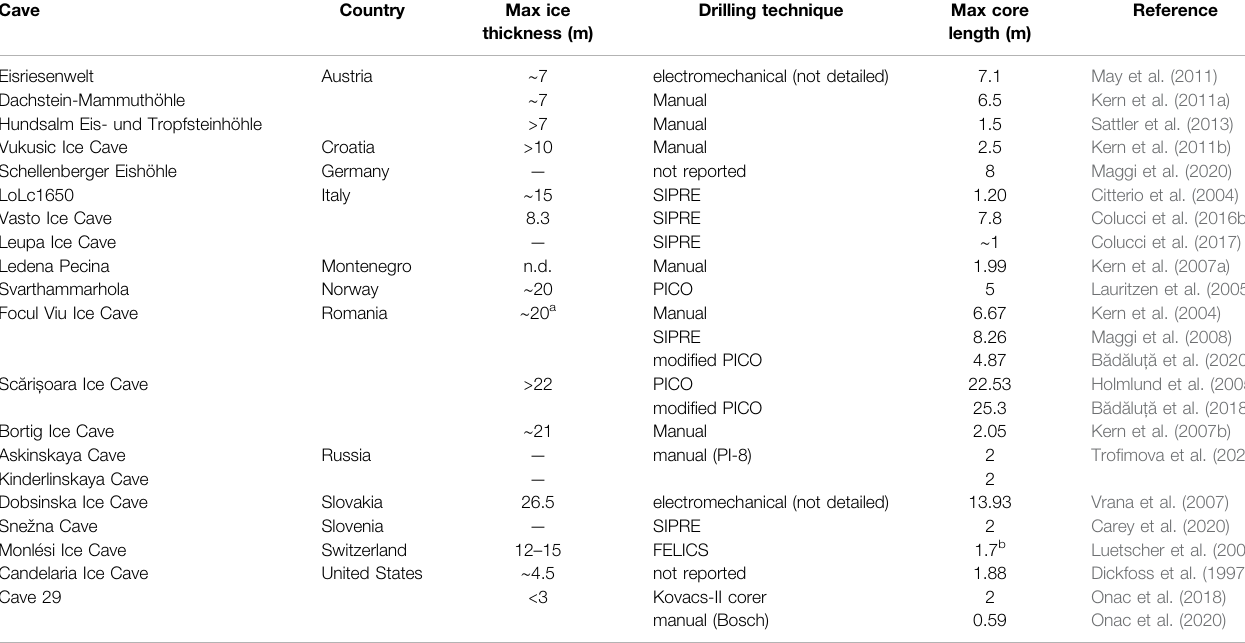
TABLE 1 | Published cave ice drilling activities during the past 25 years.